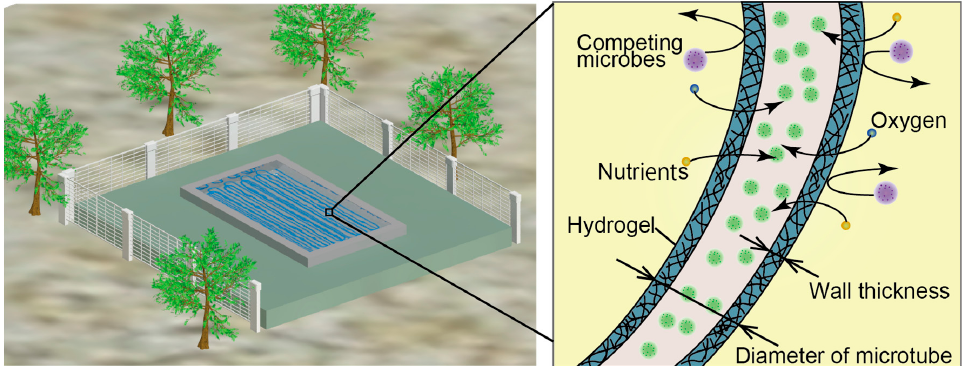
Figure 1. Open culture system with microtubes.